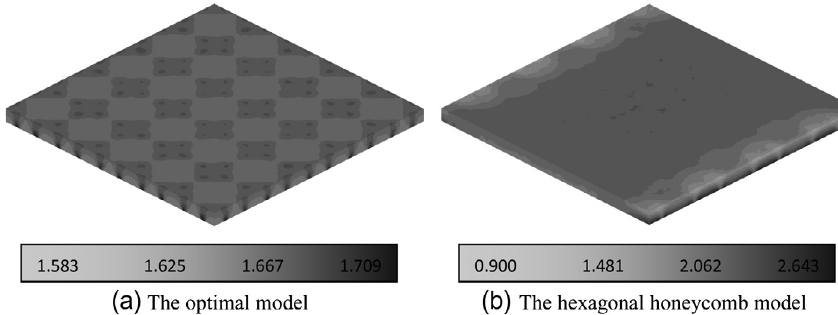
Figure 8. The thermal stress distribution in the ceramic shell under temperature load (Mpa).